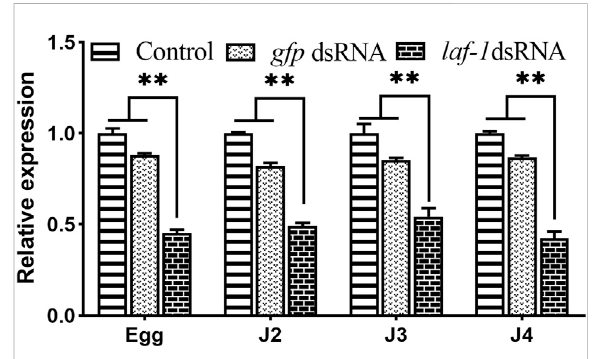
FIGURE 6 Real-time quantitative PCR analysis of Bxy-laf-1 expression levels after RNAi soaking at different developmental stages in B. xylophilus .Egg,theembryo-stage; J2,thesecond-stage juveniles; J3, the third-stage juveniles; J4, the forth-stage juveniles. Control, the no probe control, means that nematodes were treated with soaking buffer alone; gfp dsRNA, the negative control means that nematodes were treated with gfp dsRNA; Bxy-laf-1 dsRNA,meansthatnematodesweretreatedwith Bxy-laf-1 dsRNA; Data were normalized to those of endogenous reference genes tbb-2 and β -actin . Expression level of the control groups was considered as 100%. Asterisks indicate a signi fi cant difference between two groups (*means p < 0.05, **means p < 0.01). Error bars represent standard error of mean.